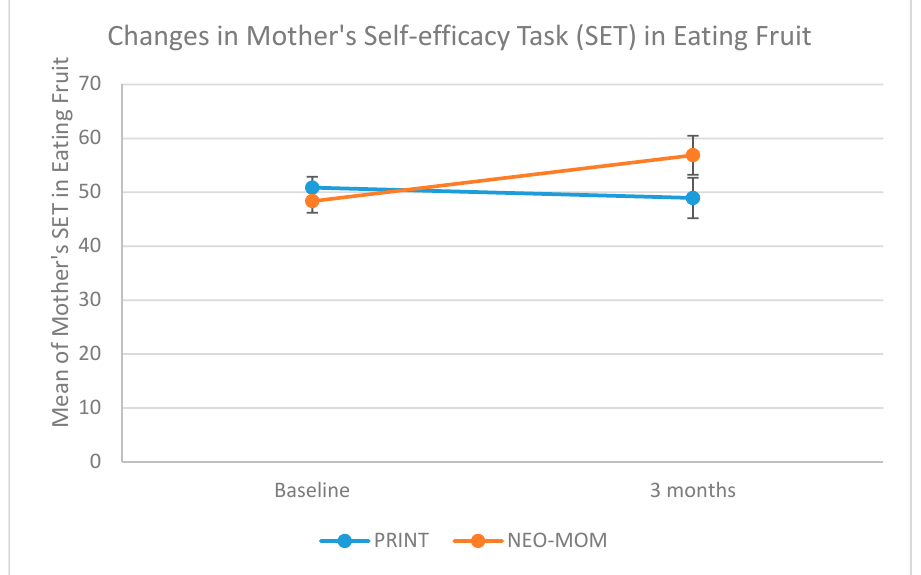
Figure 4 Profile plot of maternal self-efficacy (task) for eating fruit.